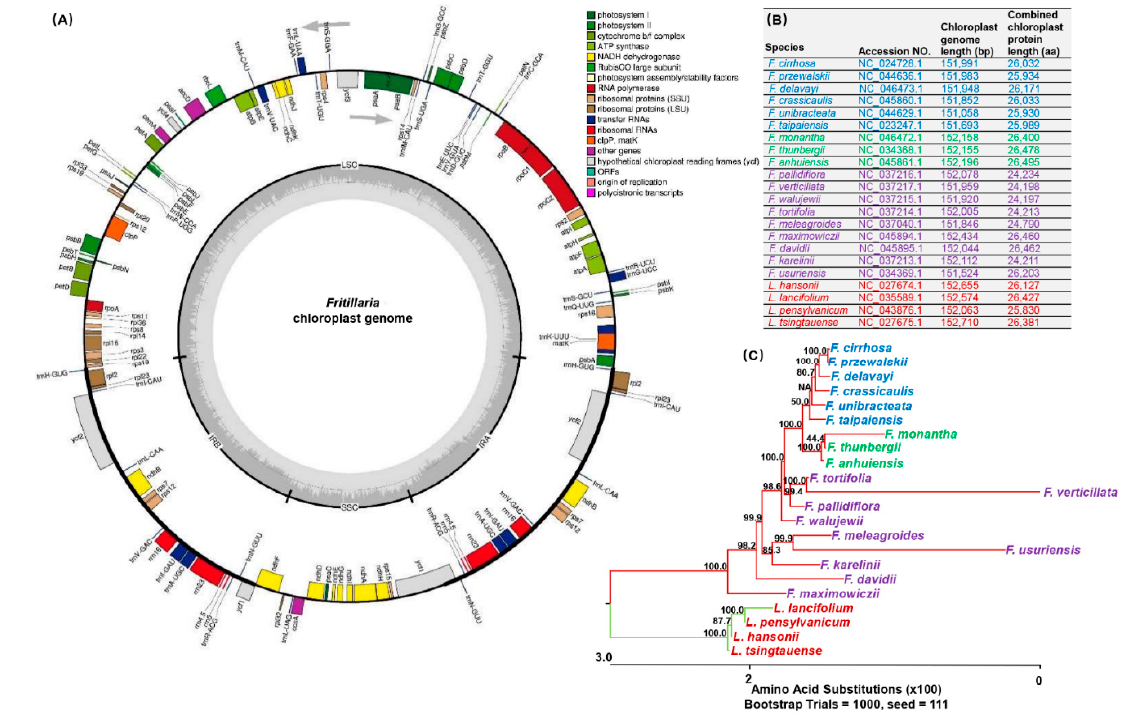
Figure 5. The phylogeny of major medicinal Fritillaria species based on the combined chloroplast protein sequences. ( A ). The chloroplast genome map of major medicinal Fritillaria. ( B )The combined chloroplast protein length of major medicinal Fritillaria species. ( C ). The phylogeny of major medicinal Fritillaria species based on the 74 combined chloroplast protein sequences. Major medicinal Fritillaria species could divide into three groups based on the evolutionary tree.